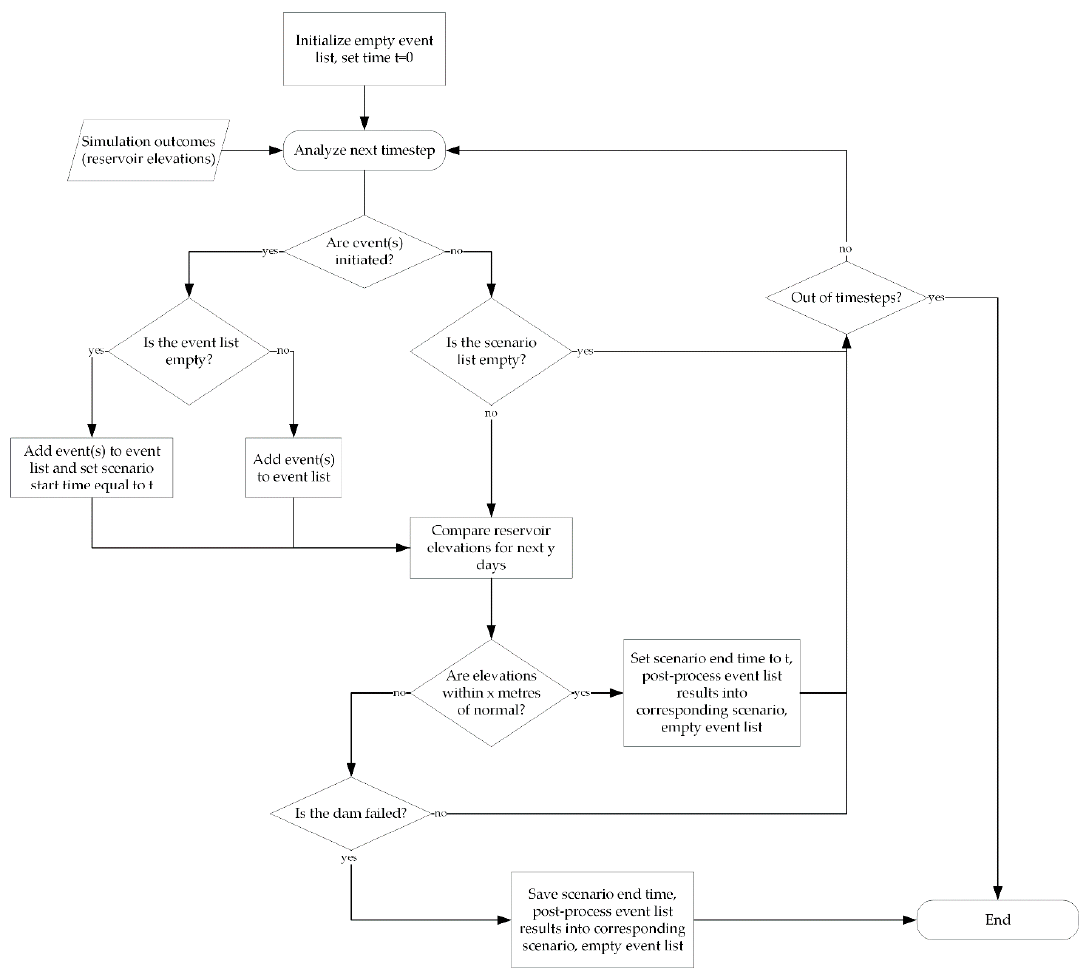
Figure 13. Event dependency algorithm.